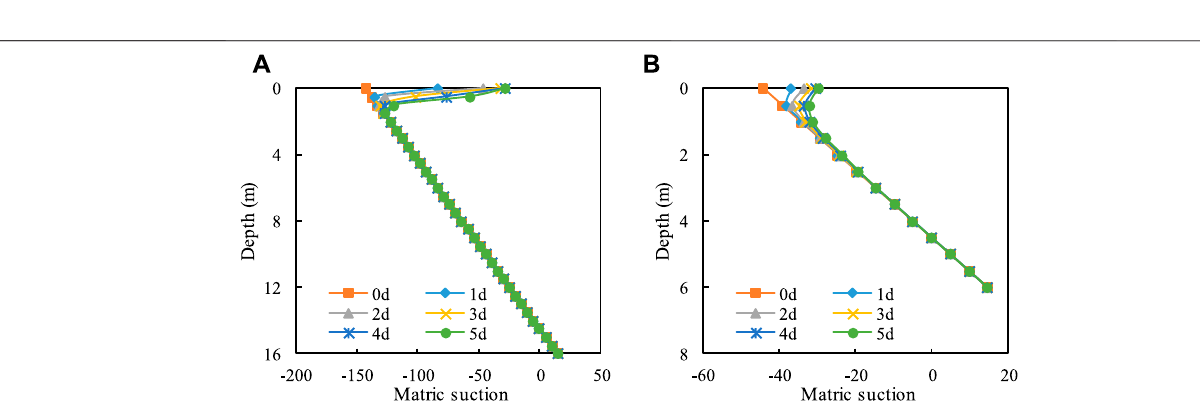
Frontiers in Earth Science |